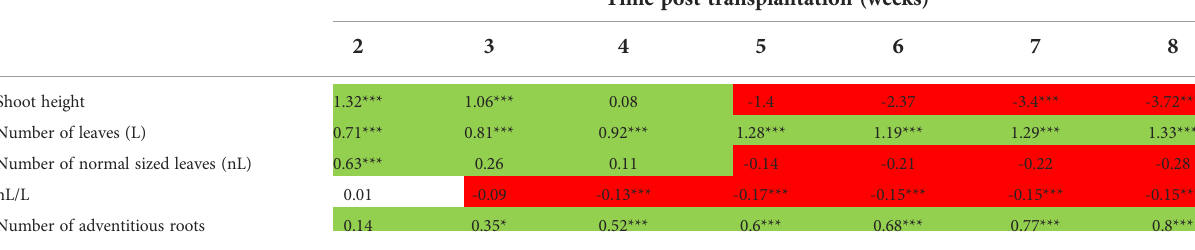
TABLE 2 Effect of treatment by the biostimulant BS on the development of grapevine in vitro plantlets.